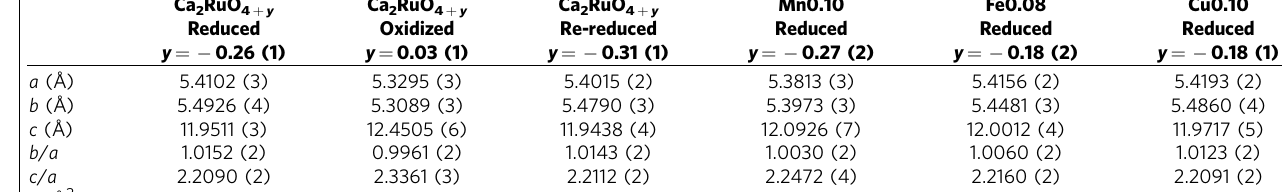
Table 2 | Crystallographic parameters of layered ruthenates obtained from Le Bail analysis of the X-ray diffraction data at 295 K. Ca 2 RuO 4 þ y